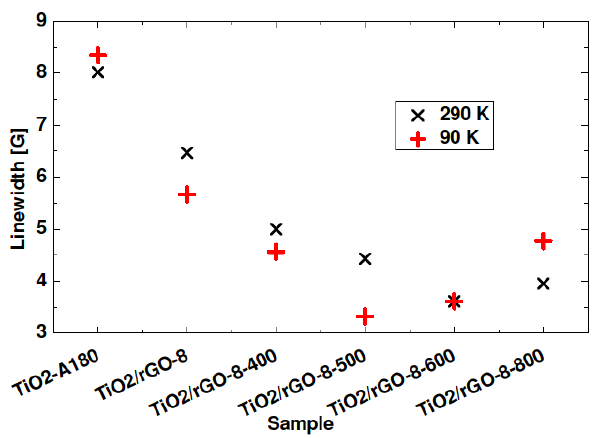
Figure 3: The linewidth ∆ H of the narrow resonance line in different samples measured at 90 K and 290 K